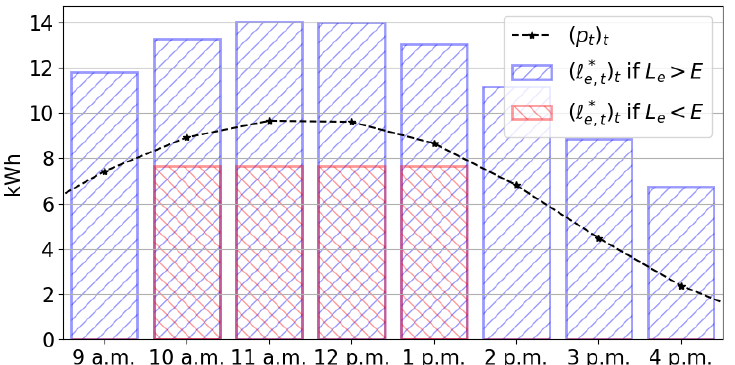
Figure 5. Water-filling optimal scheduling of the charging operation with 125 m 2 of solar panel (in black), for 15 EV (in red) and 45 EV (in blue). For 15 EV, any scheduling using only PV production is optimal, while for 45 EV, the only optimal scheduling uses the whole PV production plus the same amount from the electrical grid at each time